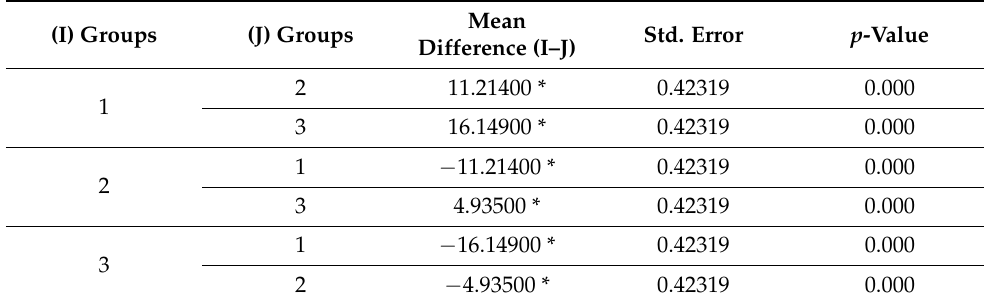
Table 3. Post hoc analysis of microtensile bond strength of core material between three different composite resins (Tukey HSD).